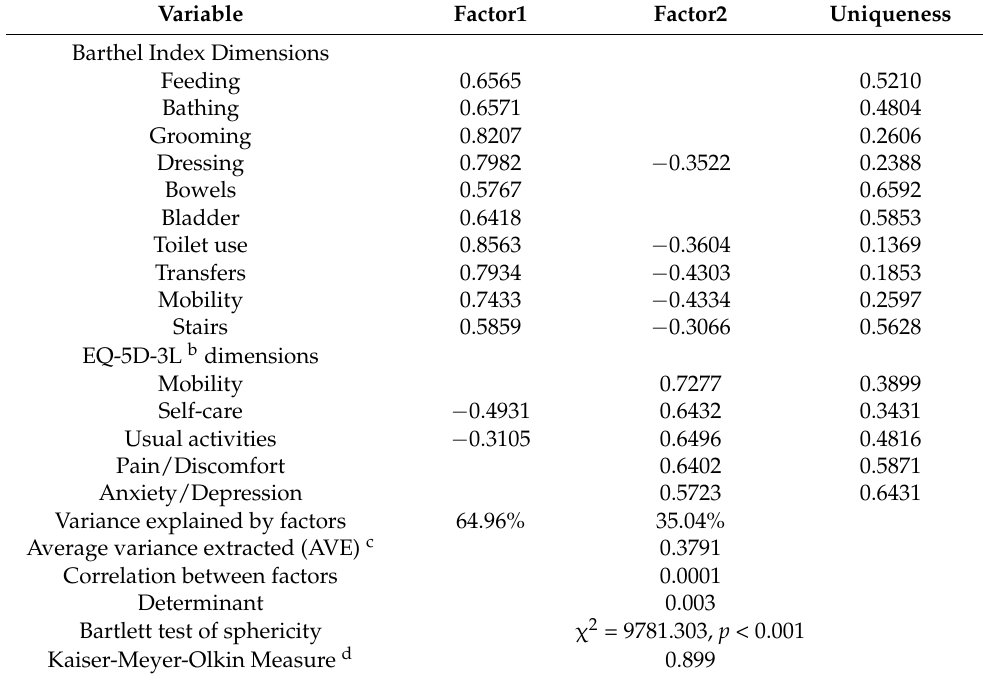
Table 4. Results of the exploratory factor analysis showing which factors the EuroQoL 5 dimensions 3 levels (EQ-5D-3L) dimensions and the Barthel Index (BI) items loaded onto a .